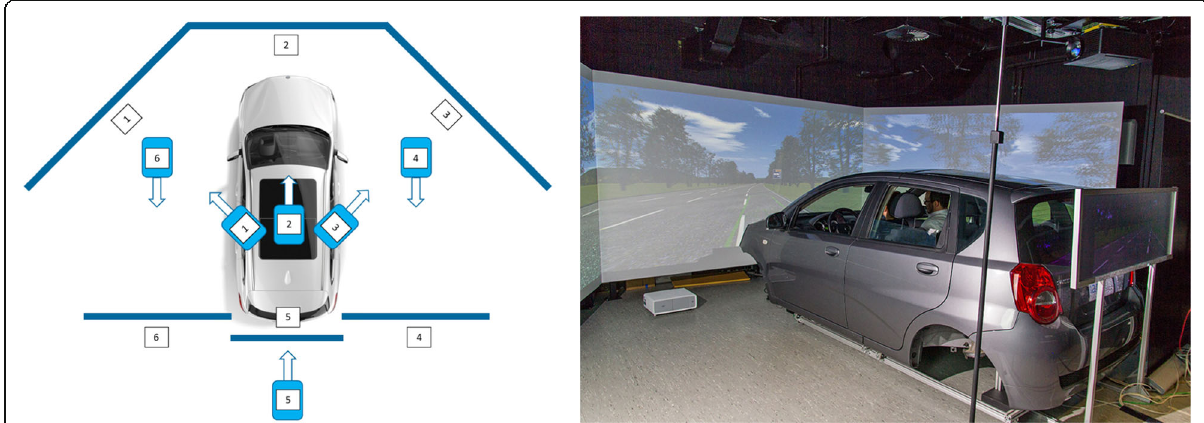
Fig. 1 Schematic structure of the used driving